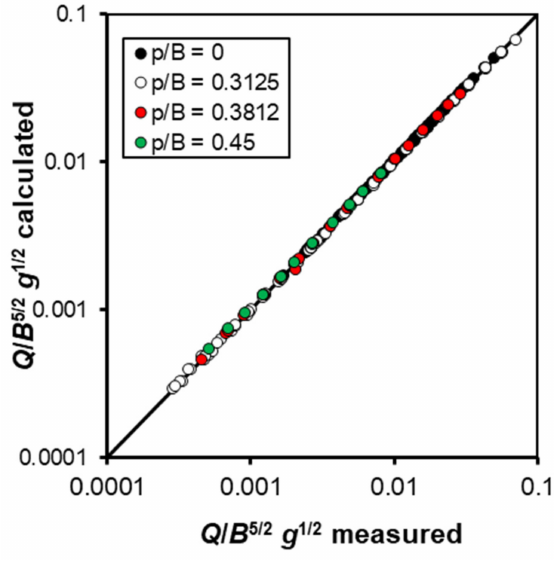
Figure 5. Comparison between the measured Q for testing dataset.